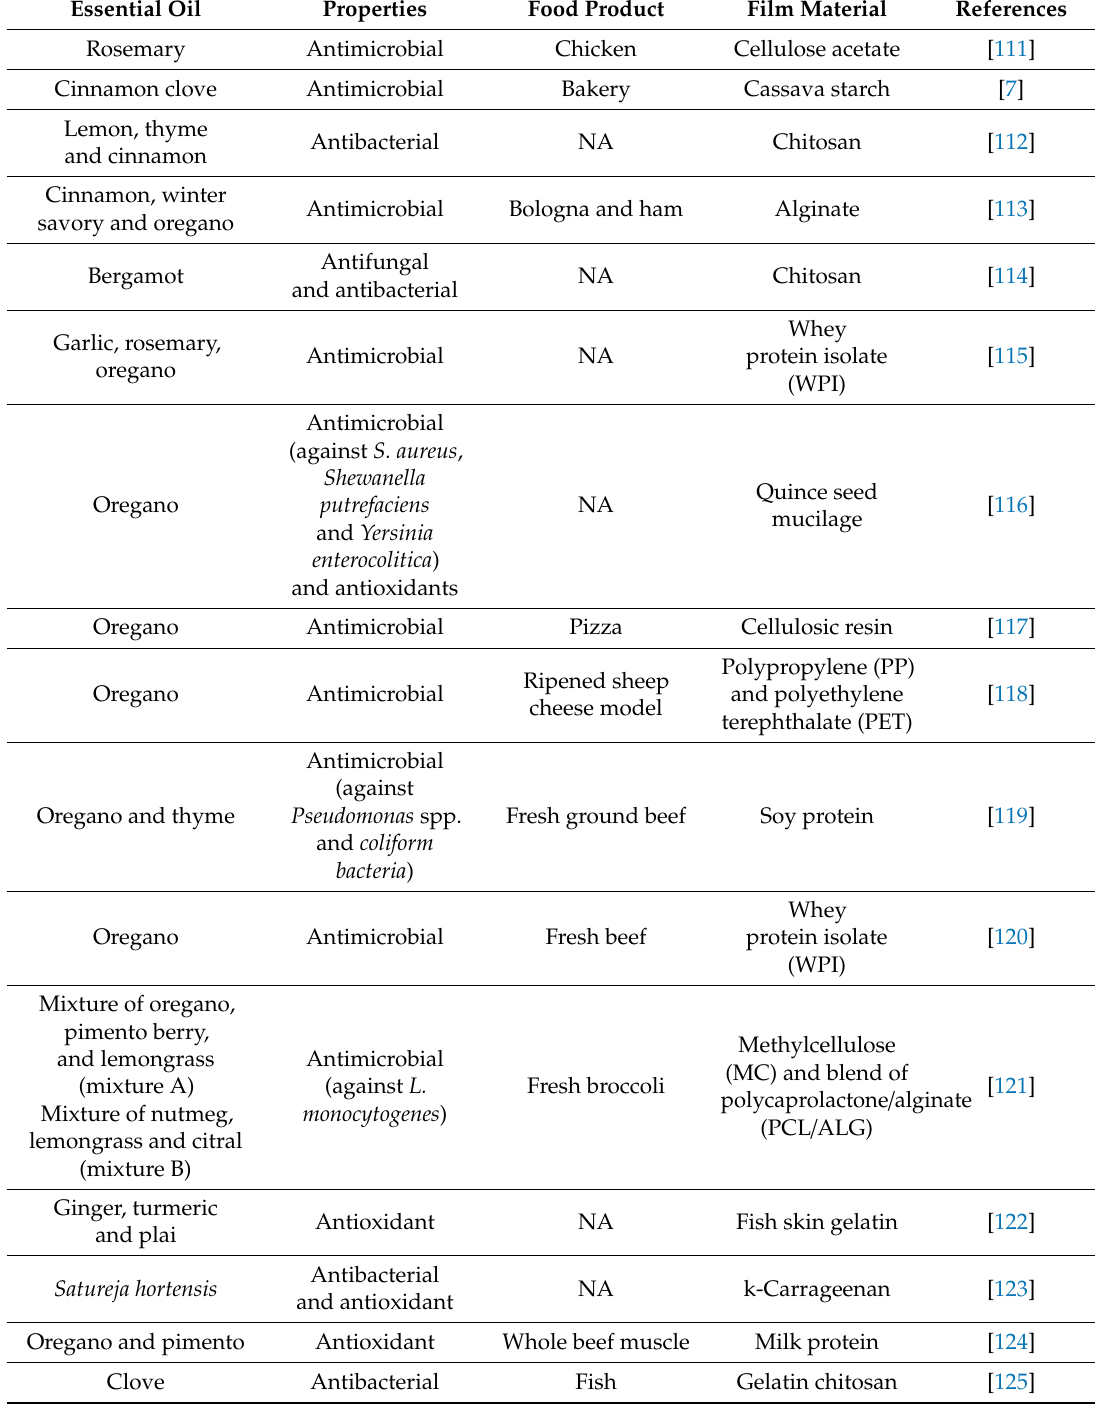
Table 4. Antimicrobial properties of polymer composites reinforced essential